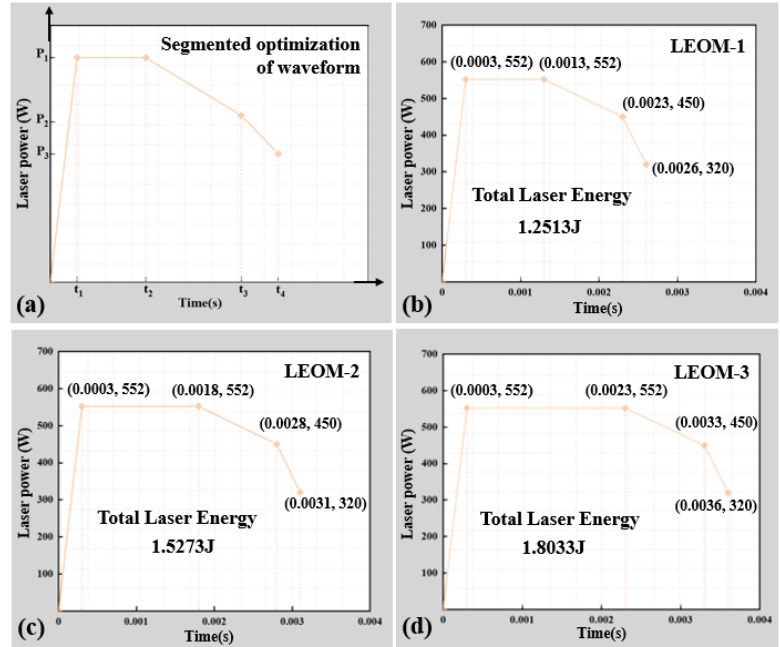
Figure 11. ( a ) A four-segment waveform optimization method. ( b ) LEOM-1; ( c ) LEOM-2; ( d ) LEOM-3. LEOM, laser energy optimization mode.